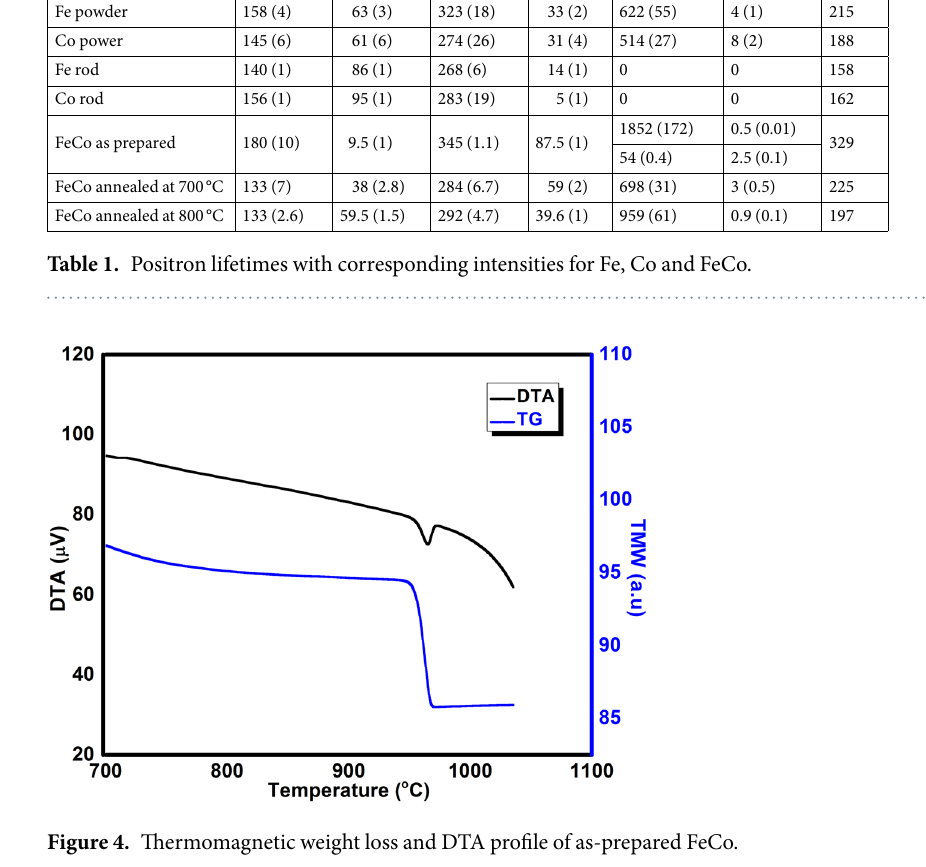
Figure 4. Thermomagnetic weight loss and DTA profile of as-prepared